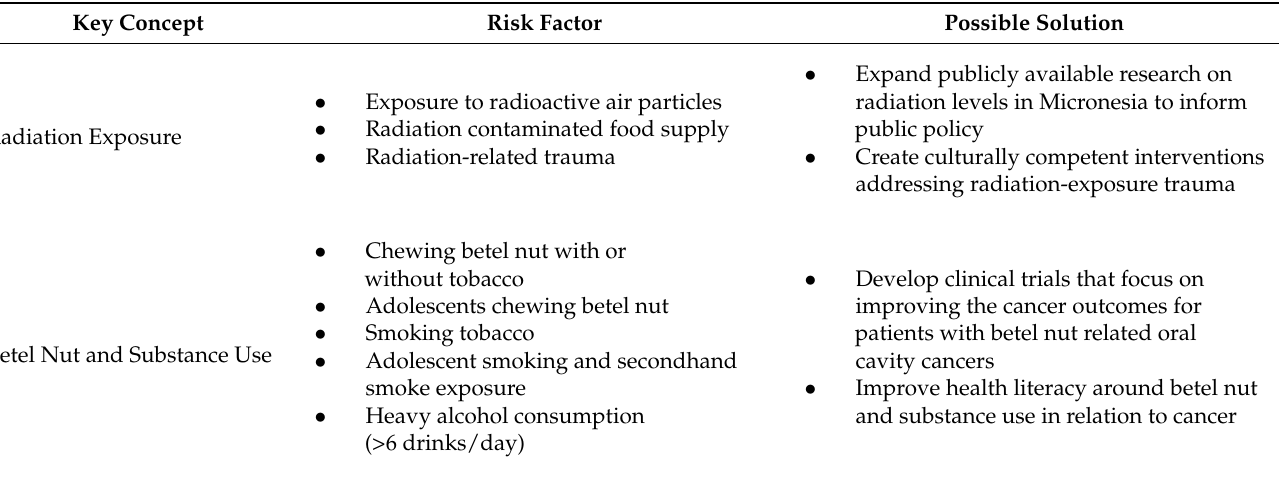
Table 3. Risk factors and possible solutions for radiation exposures and substances related to Micronesians with respect to